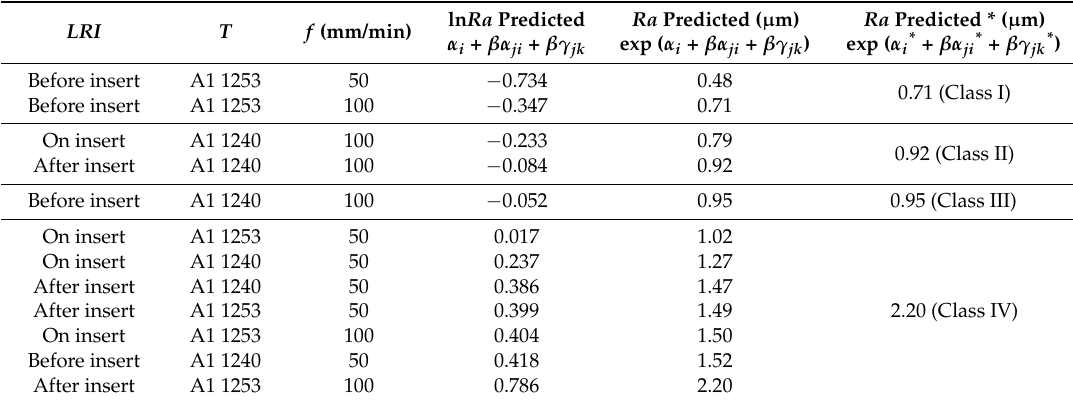
Table 11. Predicted roughness of the level combinations of significant effects on dry drilling.